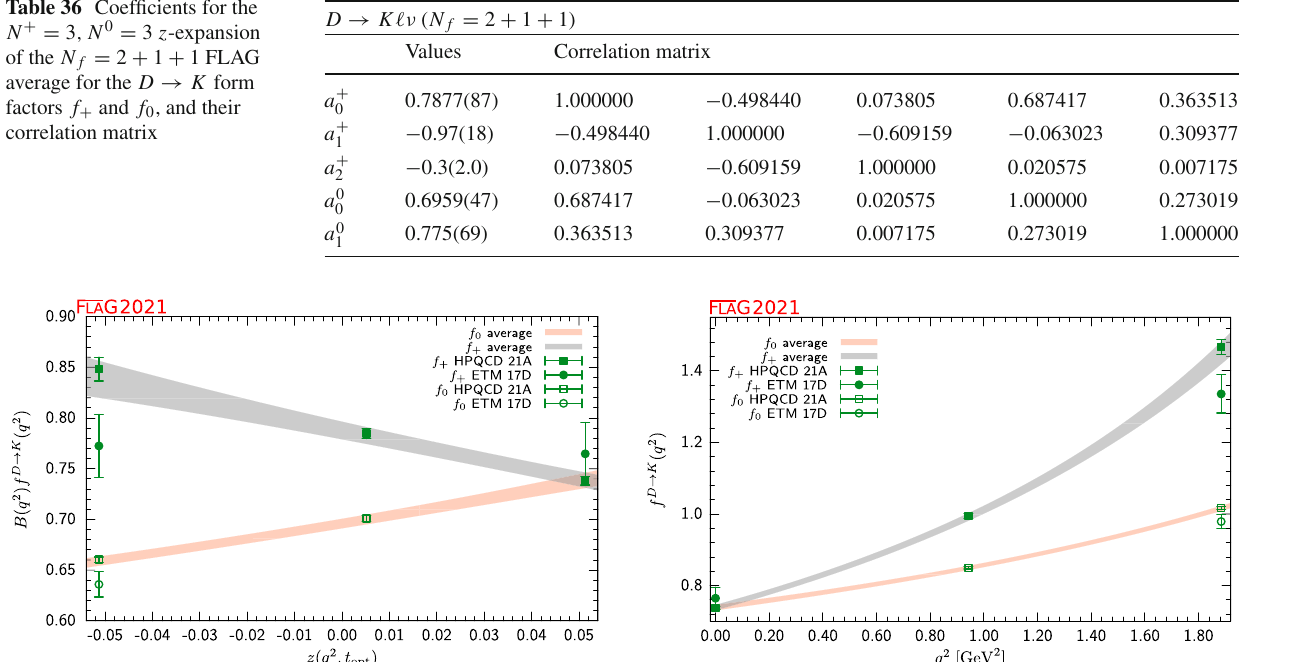
Fig. 24 The form factors f + ( q 2 ) and f 0 ( q 2 ) for D → K (cid:6)ν plotted versus z (left panel) and q 2 (right panel). In the left plot, we removed the Blaschke factors. See text for a discussion of the data set. The grey and salmon bands display our preferred N + = N 0 = 3 BCL fit (five